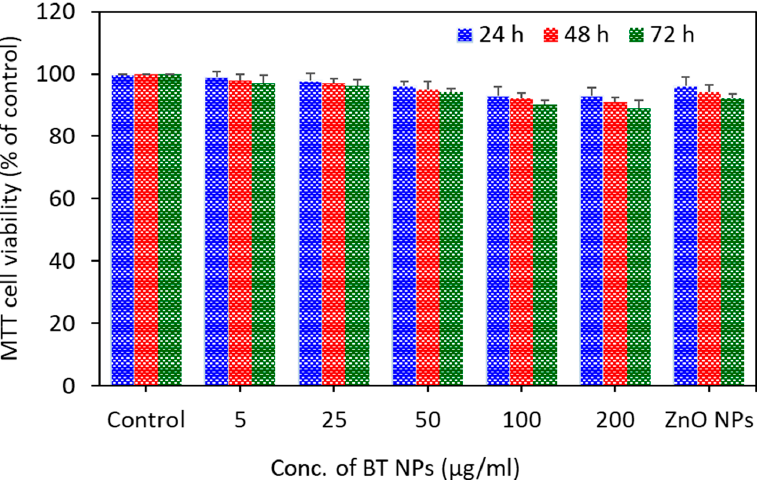
Figure 8. Effect of BaTiO 3 NPs in non-cancerous human lung fibroblasts (IMR-90). Cells were exposed for 24, 48, and 72 h to different concentrations (5–200 µg/mL) of BT NPs, and cytotoxicity was determined by MTT assay. ZnO NPs (25 µg/mL) was used as a positive control. Data are provided as mean ± SD of three independent experiments ( n = 3).